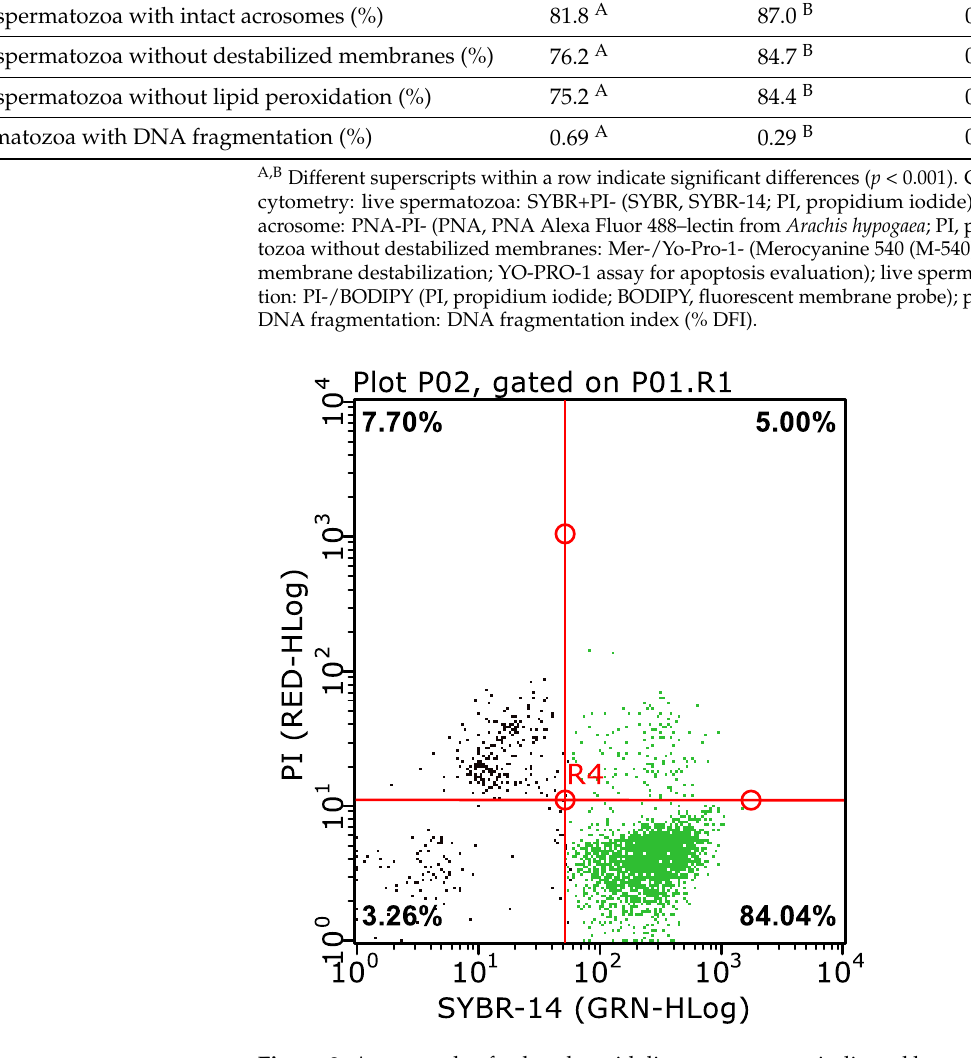
Figure 2. An example of a dot plot with live spermatozoa indicated by green dots in the Experimental group in the lower right quadrant (84.04%): SYBR+PI- (SYBR, SYBR-14; PI, propidium iodide).